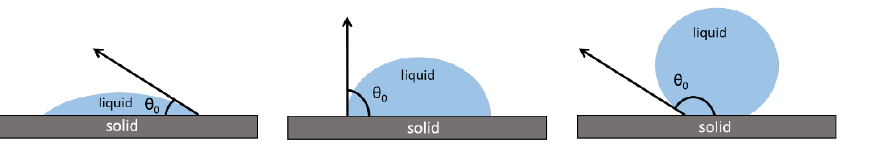
Figure 1. Contact angle of a water drop on a hydrophilic, a hydrophobic, and superhydrophobic surface.